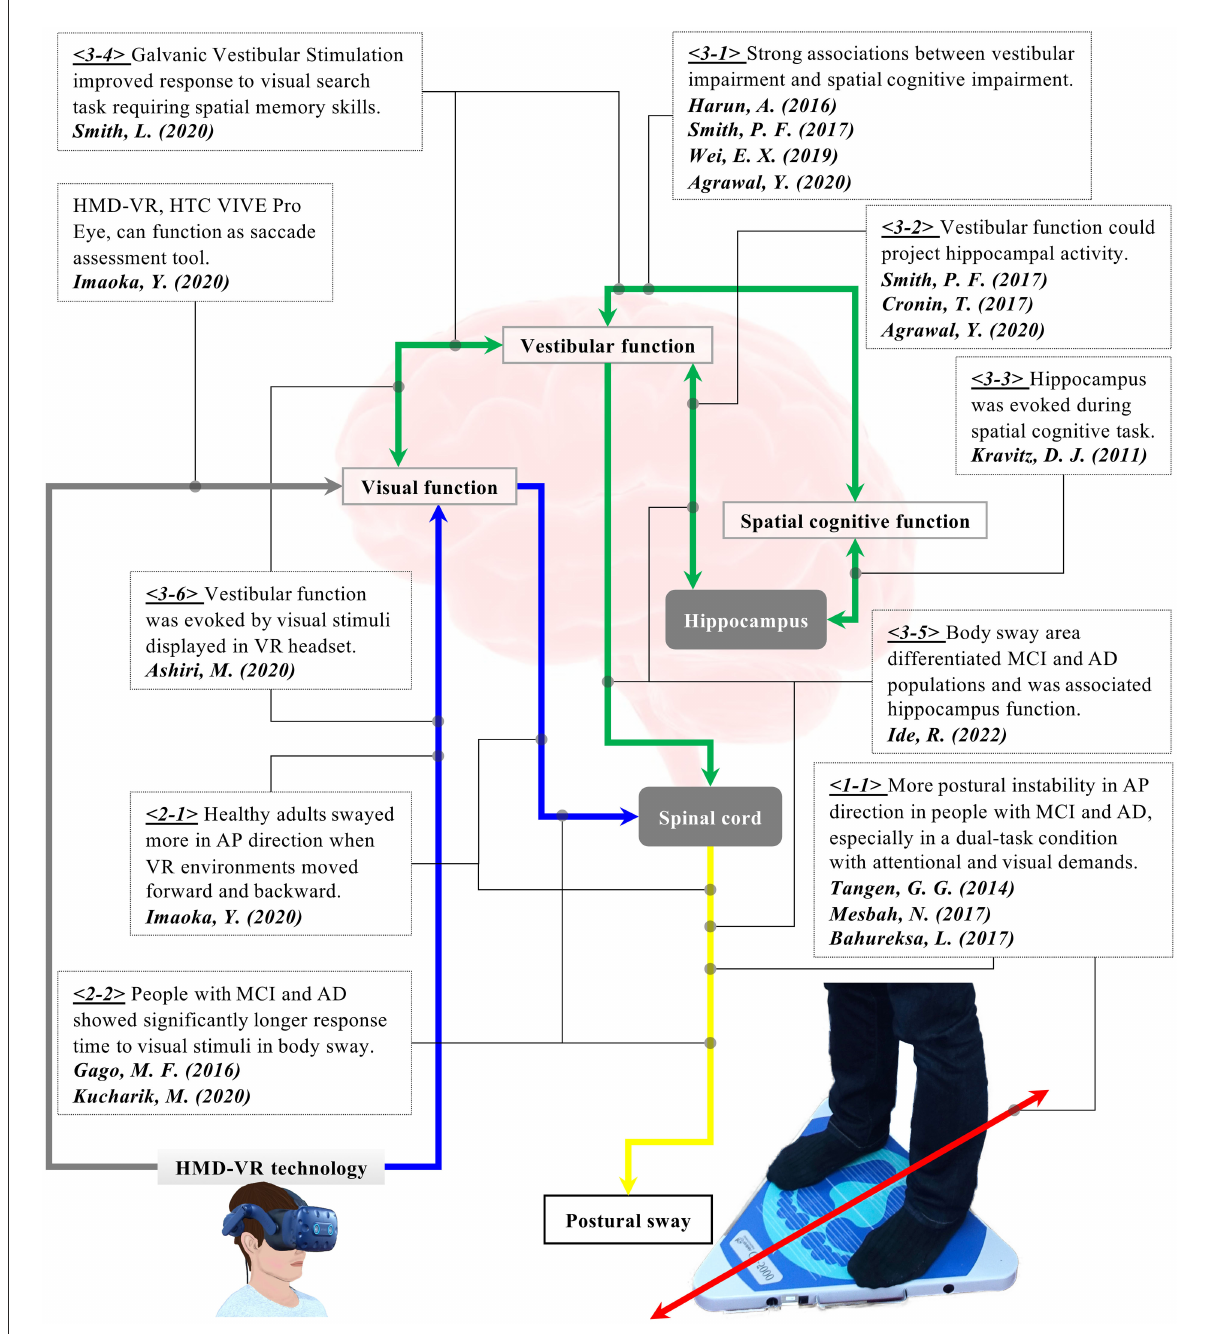
FIGURE1 Research background for the hypothesis of the present study. <1-1> People with AD and MCI showed more postural instability in the anterior-posterior direction, especially in a dual-task condition with attentional and visual demands. <2-1> Visual flow in VR affected body sway in healthy older adults. <2-2> People with AD and MCI took a longer response time to visual stimuli. <3-1> Vestibular impairment was strongly associated with cognitive impairment in people with AD and MCI. <3-2, 3-3> Vestibular function could be linked to spatial cognitive function. <3-5> Postural sway was associated with the hippocampus and could differentiate people with MCI and AD. <3-4, 3-6> Visual stimuli displayed in HMD VR environments provoked activities in the vestibular function. Stimulation of vestibular function enhanced spatial memory skills. We have hypothesized that the cognitive function could be detected through postural sway behaviors when visual stimuli are applied in VR-HMD because VR visual stimuli can provoke the vestibular function that is potentially linked to the spatial cognitive